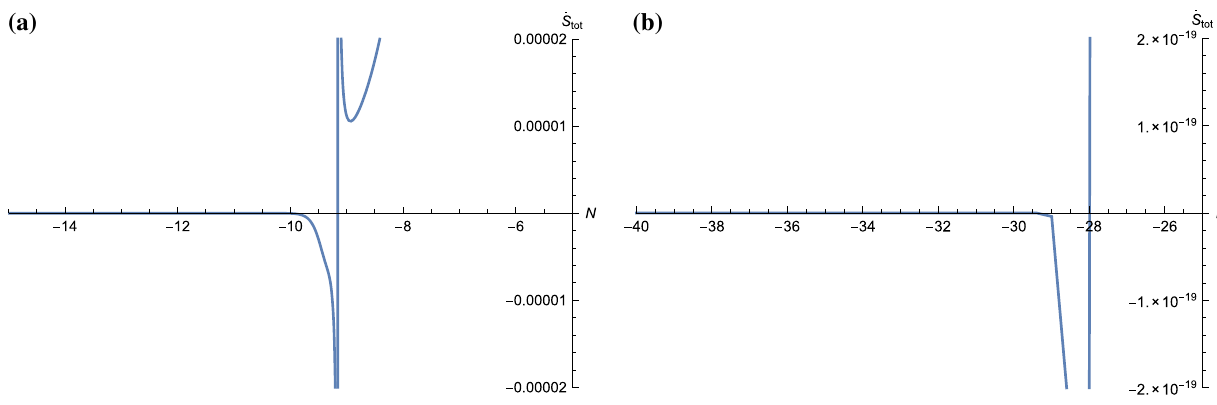
Fig. 5 Rate of change of total entropy is plotted as a function of N in freezing scenario for a α = − 0 . 3 and b α = − 0 . 1